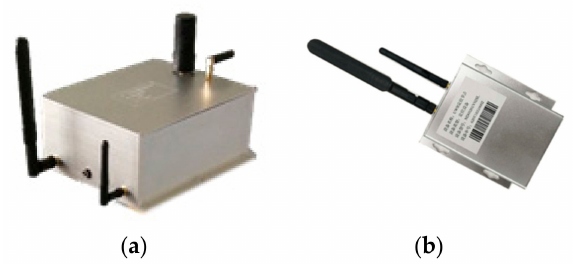
Figure 1. The indoor and outdoor seamless positioning devices. ( a ) Global Navigation Satellite System / Ultra-Wideband (GNSS / UWB) seamless positioning base device; ( b ) UWB anchor and tag two-in-one